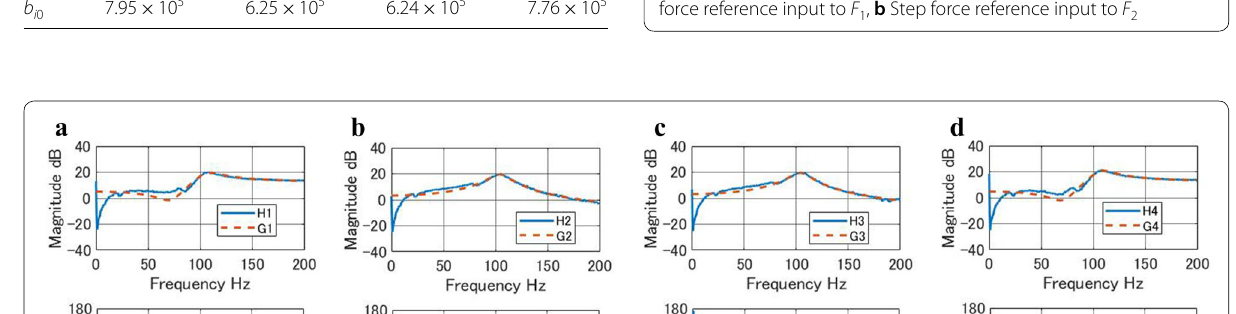
Fig. 5 Measured position difference between two tables. a Step force reference input to F 1 , b Step force reference input to F